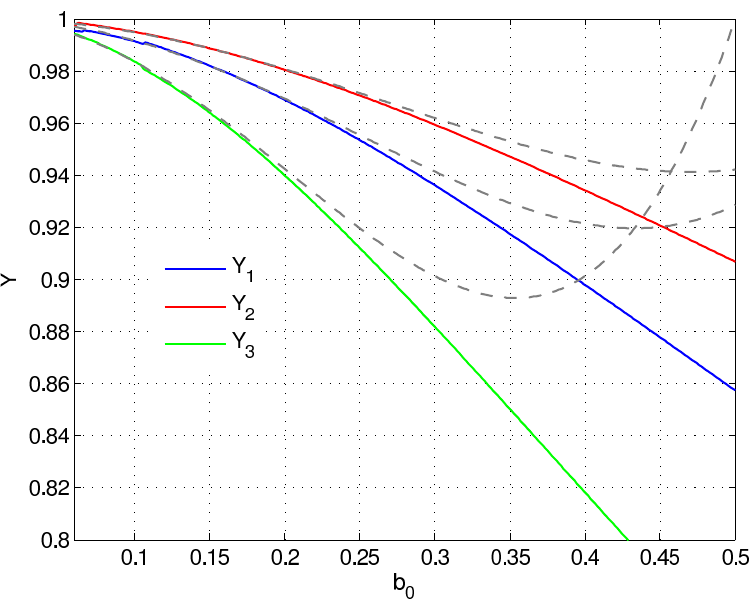
Figure 1 . An exact and an approximate Y -functions